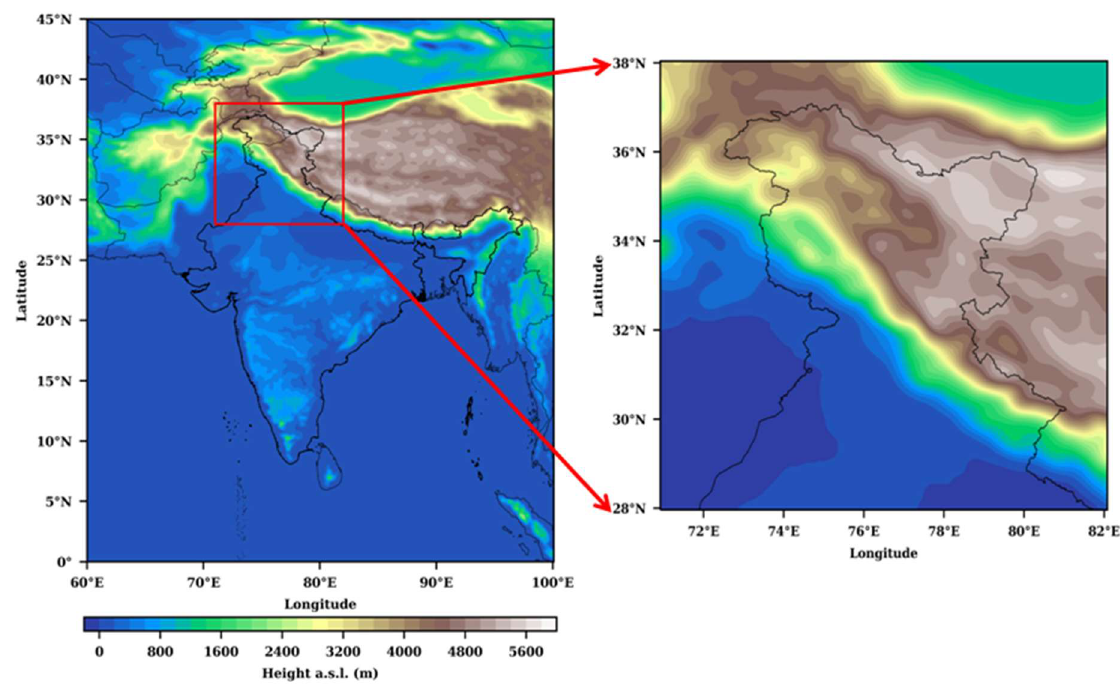
Figure 1. Topographic map from WRF, where the outlined box is the study region.